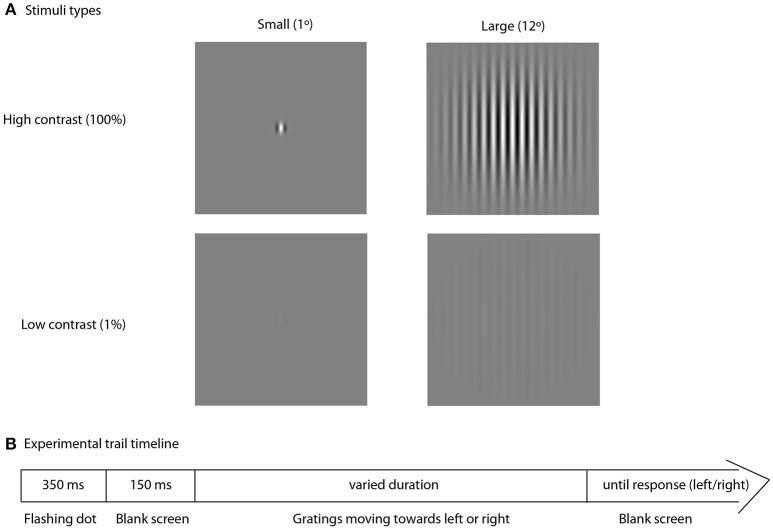
Experimental trial. Type of stimuli, used in the experiment (A) and schematic representation of the experimental trial timeline (B).